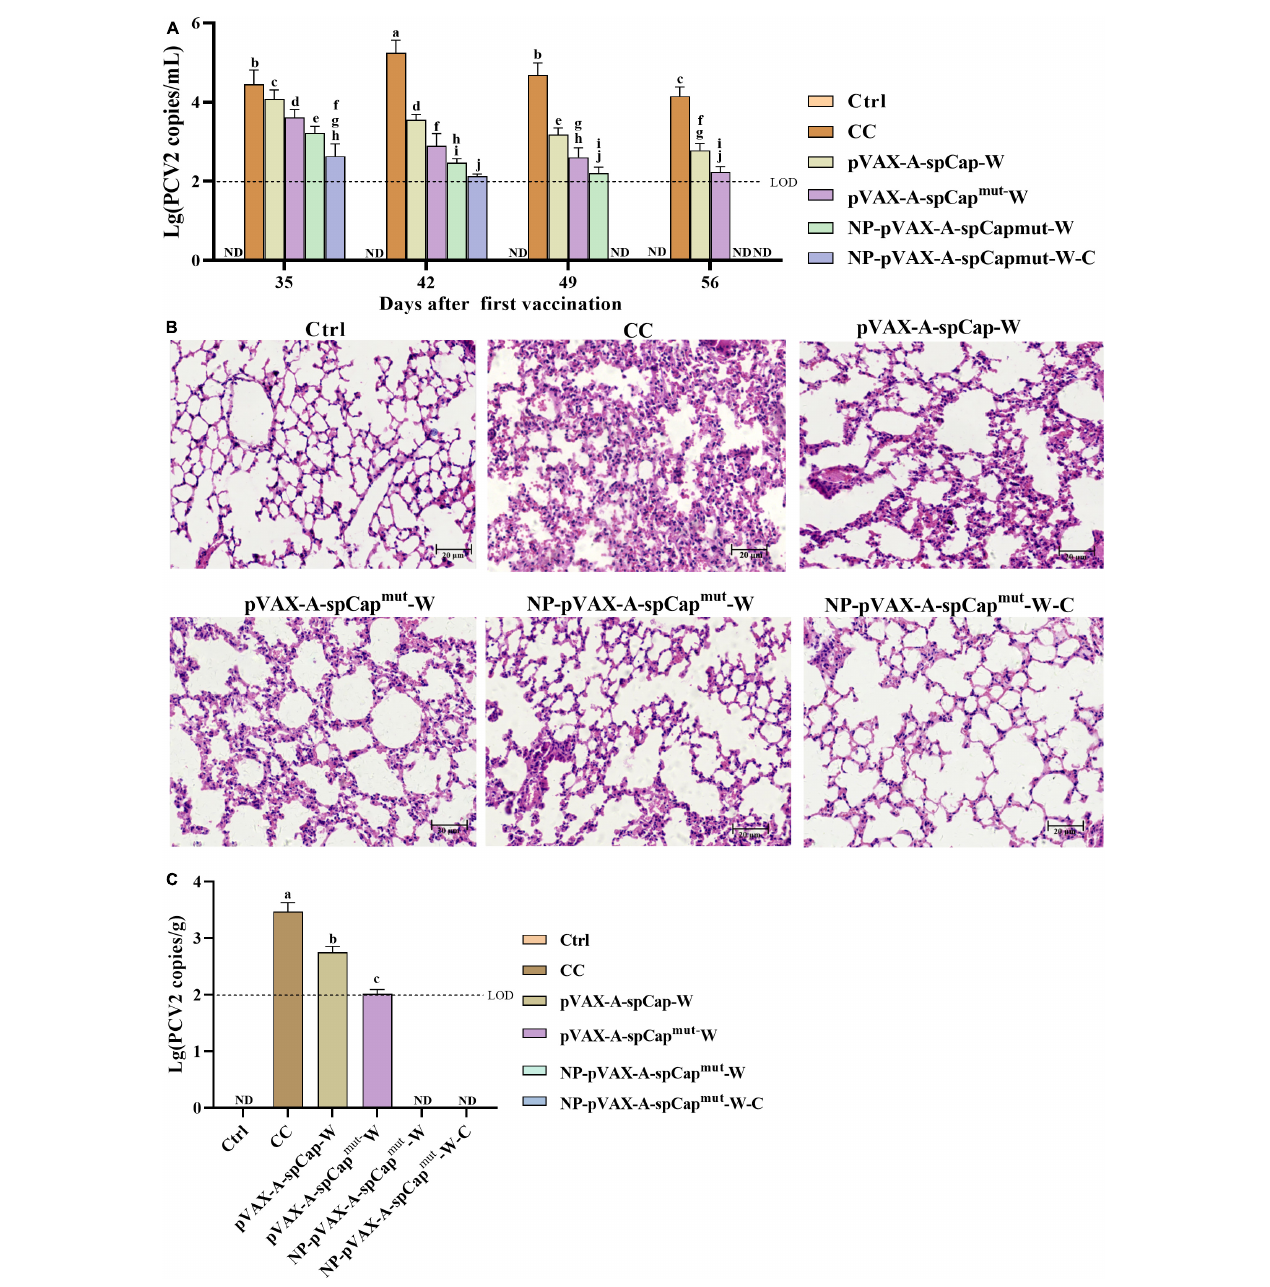
FIGURE4 The gC1qR binding site mutation Cap is more efficient in protecting mice from porcine circovirus type 2 (PCV2) infection and the viral infection-induced lung lesions. (A) The PCV2 copy numbers in the serum of the different groups mice were measured by qPCR every 7 days after challenge. (B) At 56 days post-vaccination, all groups mice were euthanized, the lungs were made into paraffin tissue sections, stained with HE, and the pathological changes of the lung tissues were observed with a microscope. (C) The PCV2 copy numbers in the lungs of the different groups mice were measured by qPCR at 56 days post-vaccination. Bar = 20 µ m. ND means not detected, and the same small letters (a ∼ j) represent no significant difference among the groups, and different small letters represent significant differences among the groups in (A)